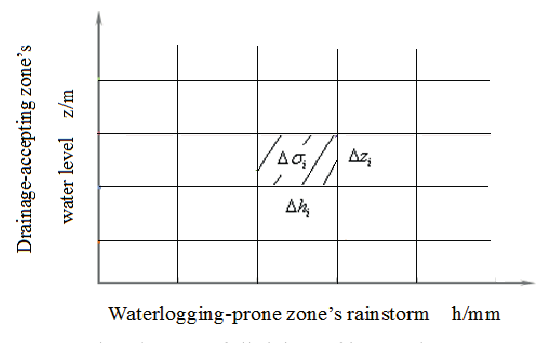
Fig. 1 Sketch map of division of integral